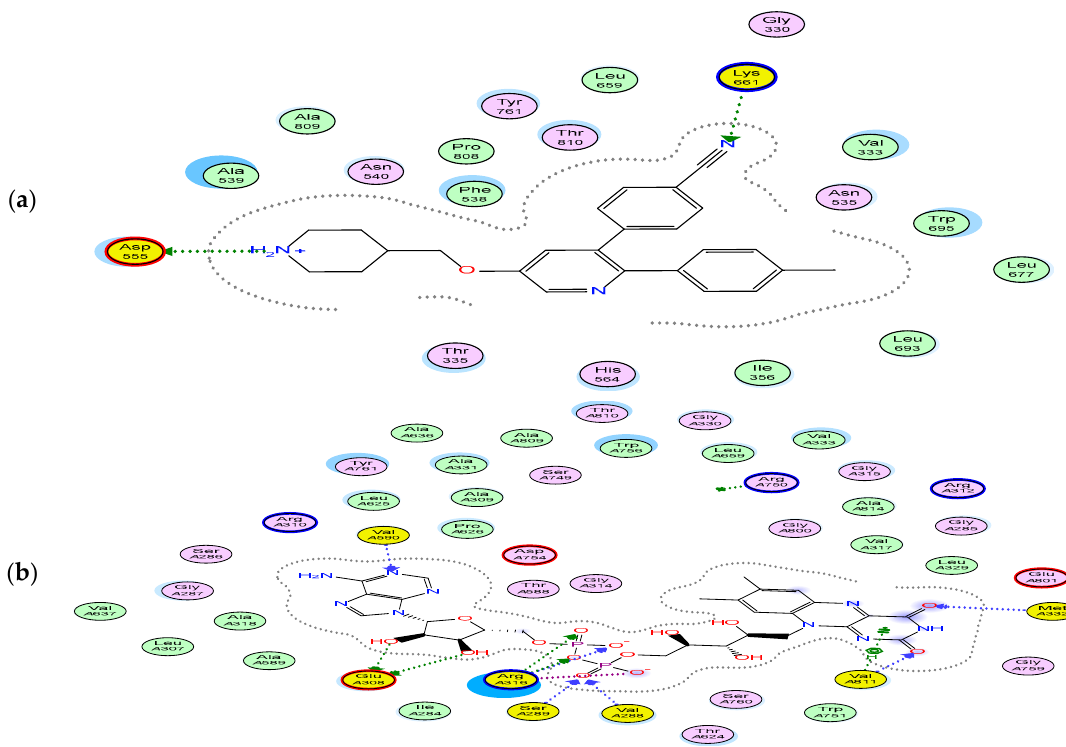
Figure 6. ( a ) 2D binding mode and residues involved in the recognition of cocrystallized ligand (LSD 1 inhibitor) from 5YJB PDB Lys661 and Asp 555. ( b ) 2D binding mode and residues involved in the recognition of FAD; Try 761, Arg 310, Arg 316, Val 333, Met 332, Glu A801, Ser 209, Glu 309, and Val 590 (with yellow